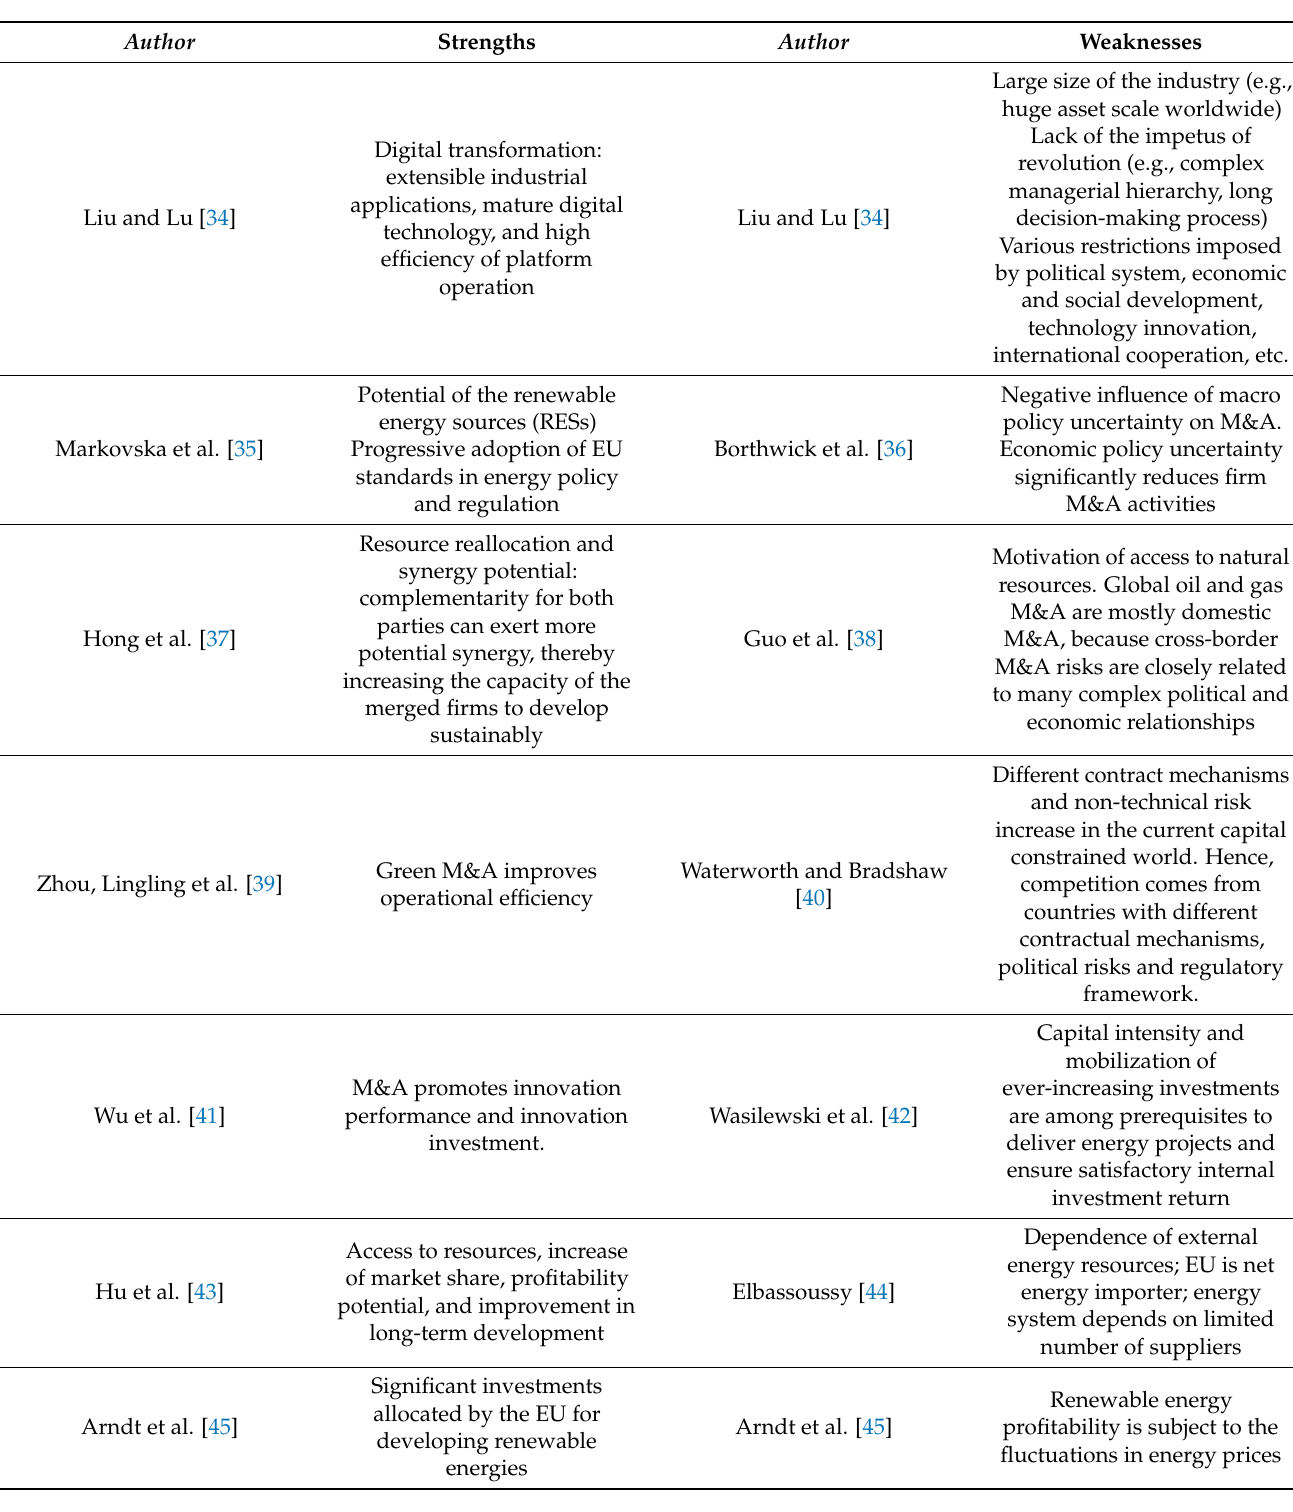
Table 1. Results of M&A SWOT analysis of the energy industry from the perspective of sustainable